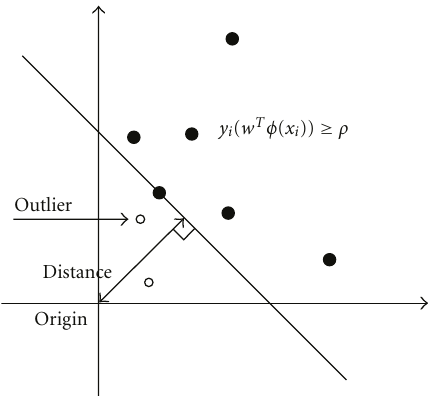
Figure 3: One-class SVM; the origin means the only original member of second